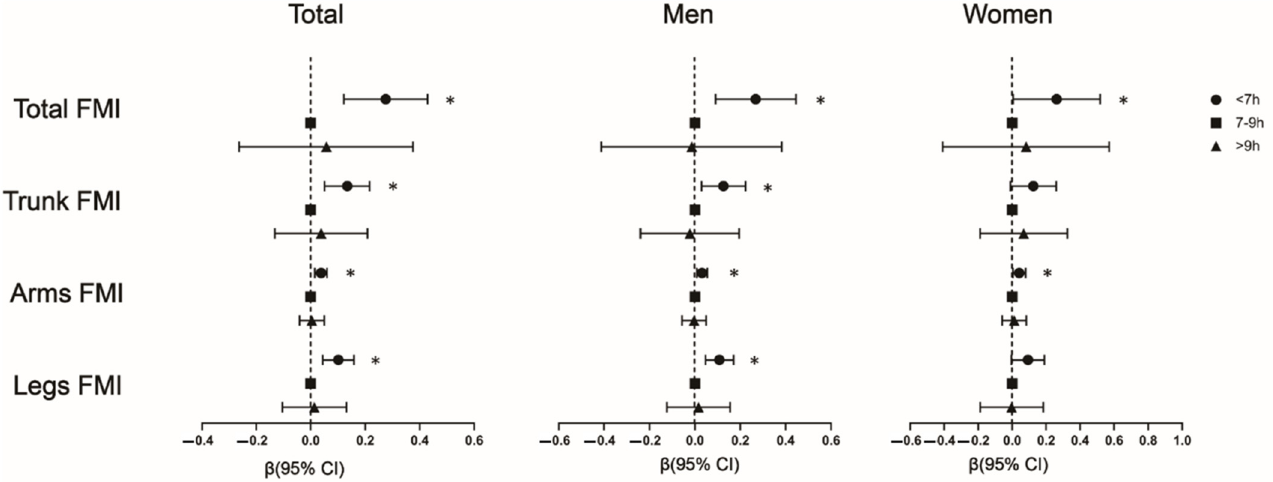
Figure 2. Multivariable linear regression of sleep duration groups with different regional fat mass. Adjusted confounders include age, race, sex (only in total), education level, marital status, physical activity, sedentary activity, work, diabetes, diabetes treatment, use of stain, smoke, alcohol, total cholesterol and low-density lipoprotein. Compared to the normal sleep group, the short sleep group was more likely to have increased different regional FMI in total and in men, while short sleepers only have higher total FMI and arms FMI in women. No significant difference was found in long sleepers. * (Higher than normal sleep duration groups) represents p < 0.05. FMI: fat mass Table 4. Association between different regional fat mass and sleep duration groups in obese groups.